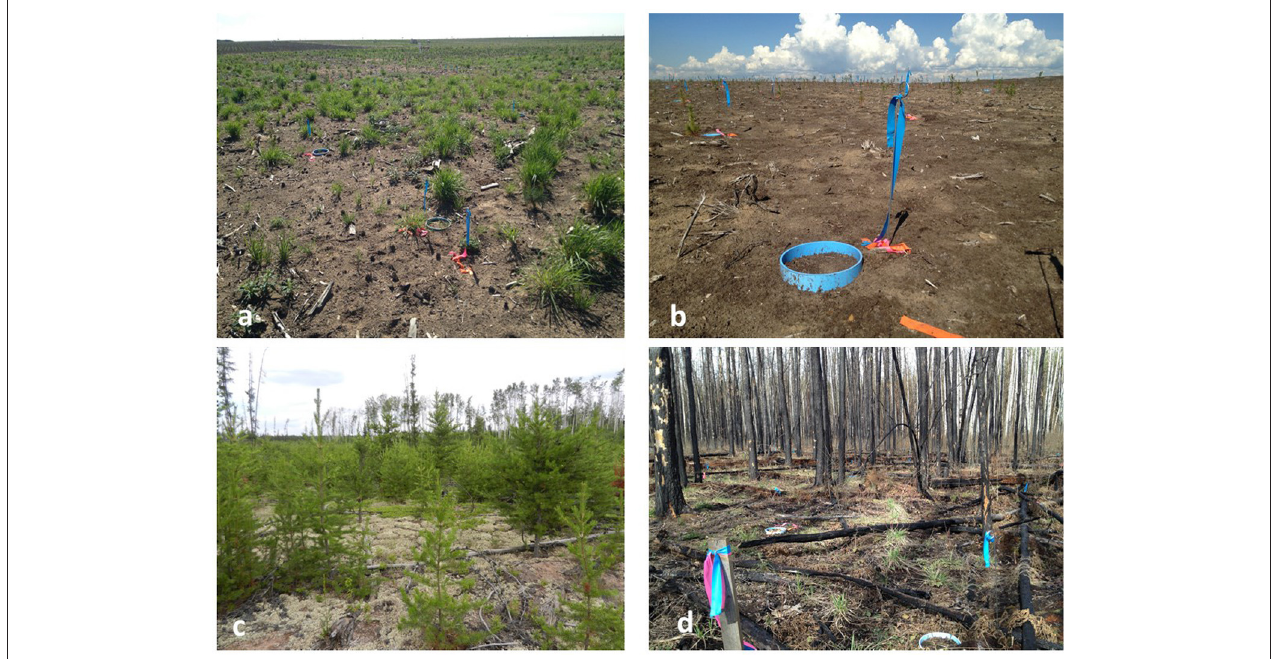
FIGURE 1 | Pictures of sites compared in this study. (a) Forest Floor Mineral Mix (FFM) reclaimed site; (b) Peat Mineral Mix (PM) reclaimed site; (c) Harvested ab ecosite; (d) Fire b ecosite.